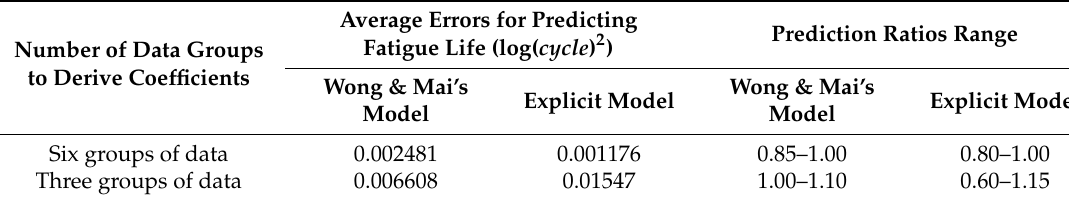
Figure 9. Prediction ratio for stainless steel 316 at pure fatigue.